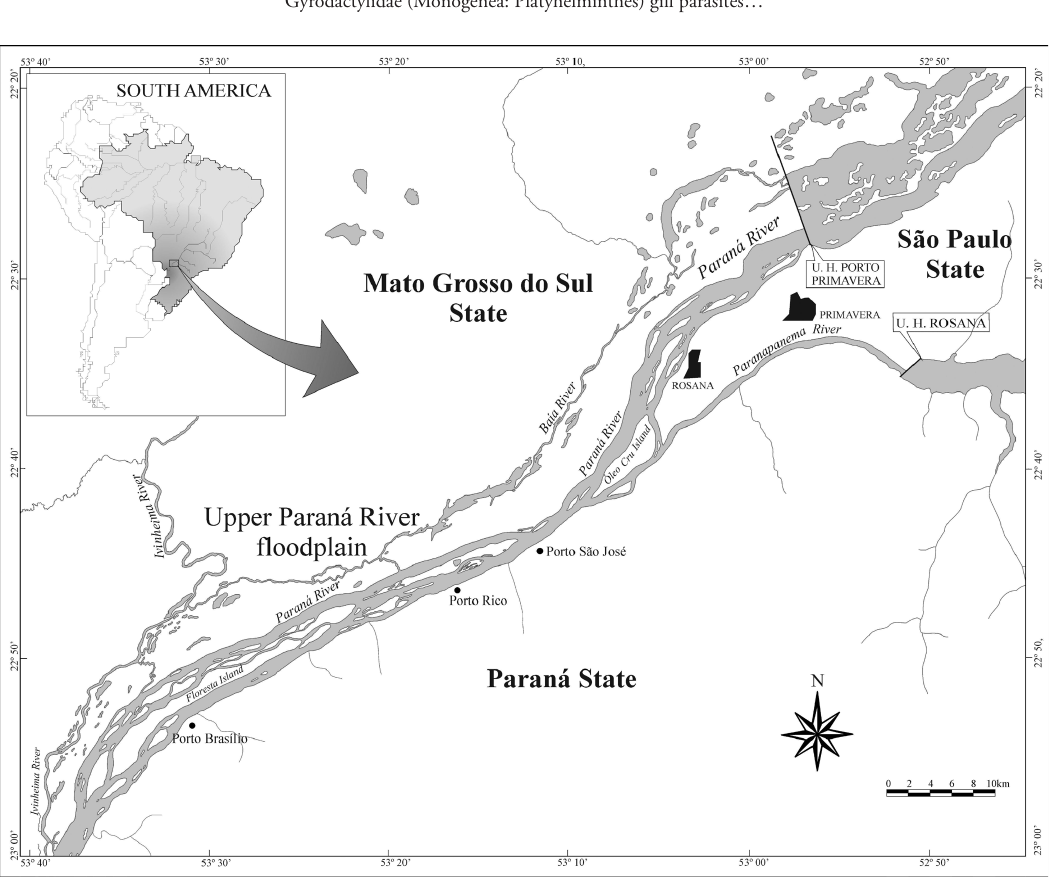
Figure 1. Map of the localization of the upper Paraná River